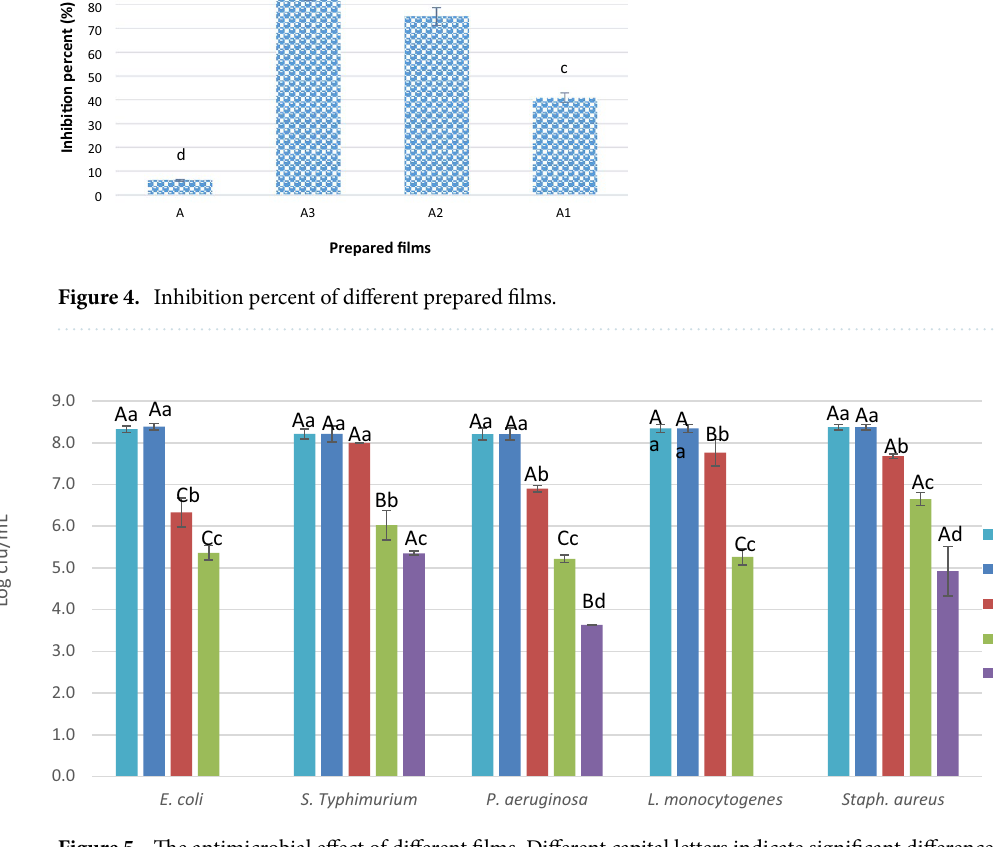
Figure 5. The antimicrobial effect of different films. Different capital letters indicate significant differences for bacterial counts within the same treatment. Small letters indicate significant differences for different treatments within the same bacteria (p < 0.05). Results represent the means of 3 replicates ±